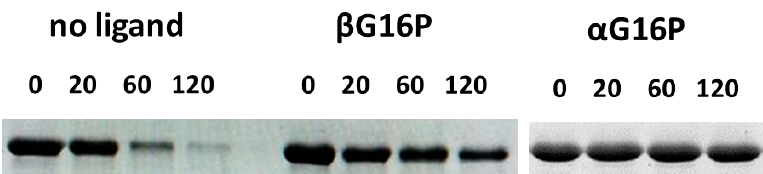
Figure 4. Limited proteolysis of wild type PMM2 by trypsin. Wild type PMM2 was incubated at 37 ◦ C with trypsin in a 50:1 ratio in the presence or the absence of β G16P or α G16P 0.5 mM. Aliquots were withdrawn at specified times (0, 20, 60, 120 min) and analyzed by SDS-PAGE and Coomassie staining.